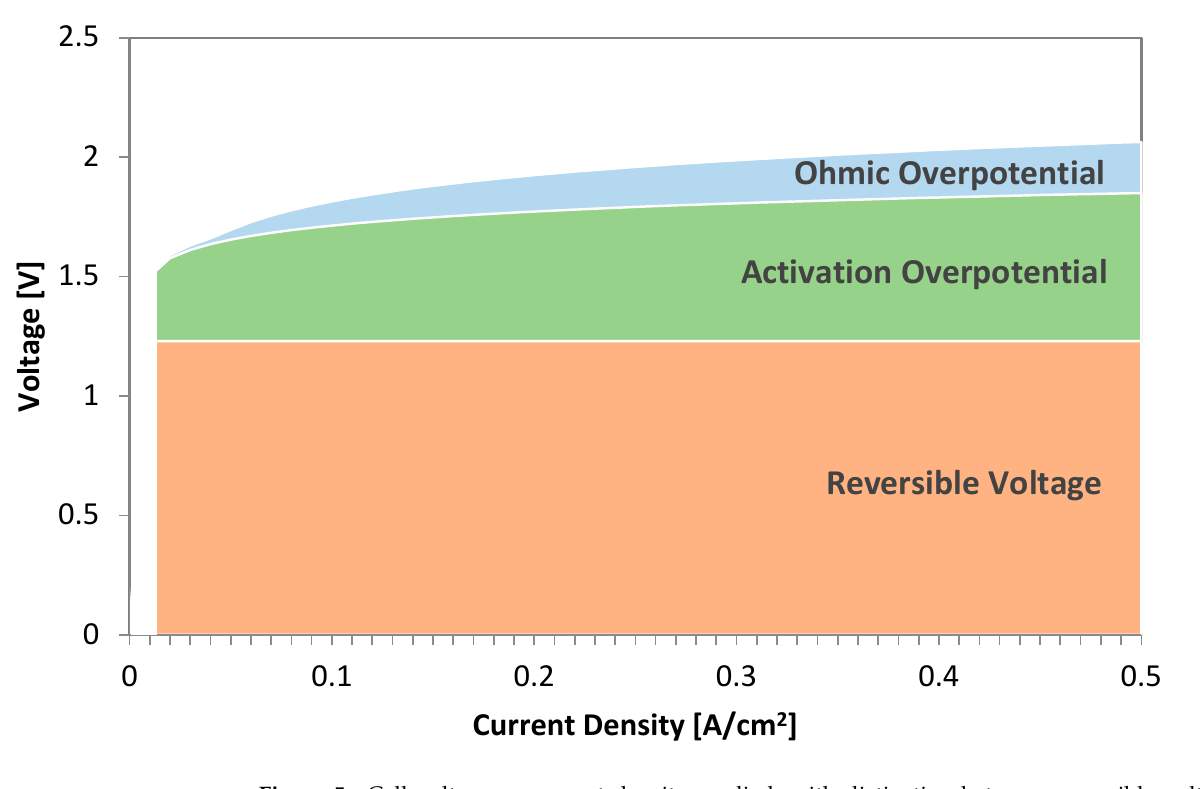
Figure 5. Cell voltage vs current density applied, with distinction between reversible voltage, activation overpotential and ohmic overpotential. Adapted from [19].